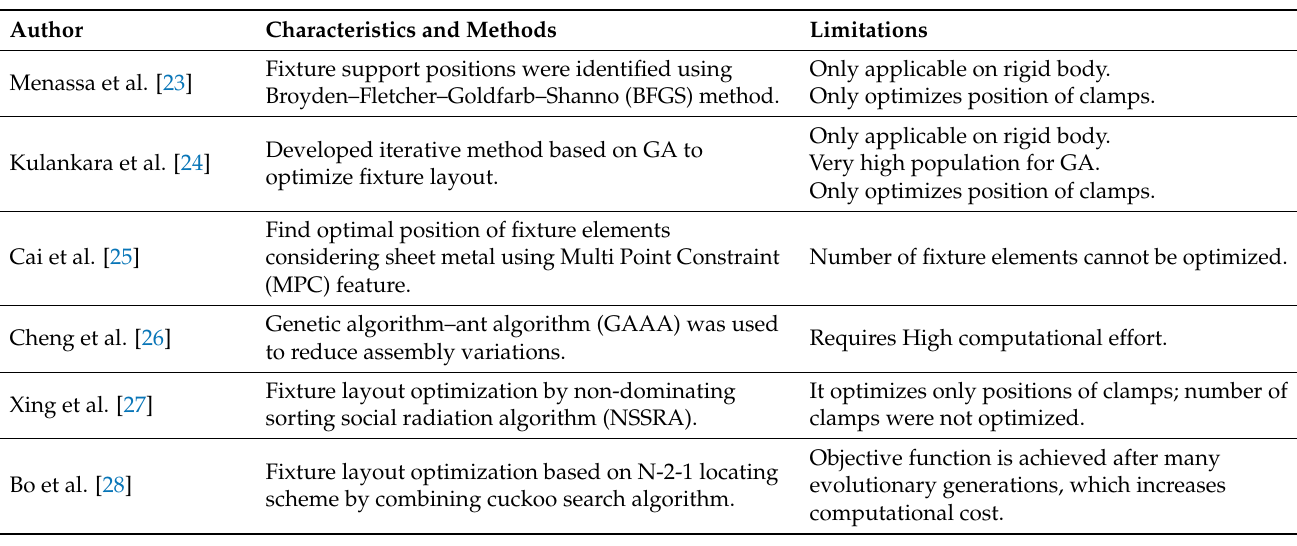
Table 1. Summary of currently existing fixture layout optimization